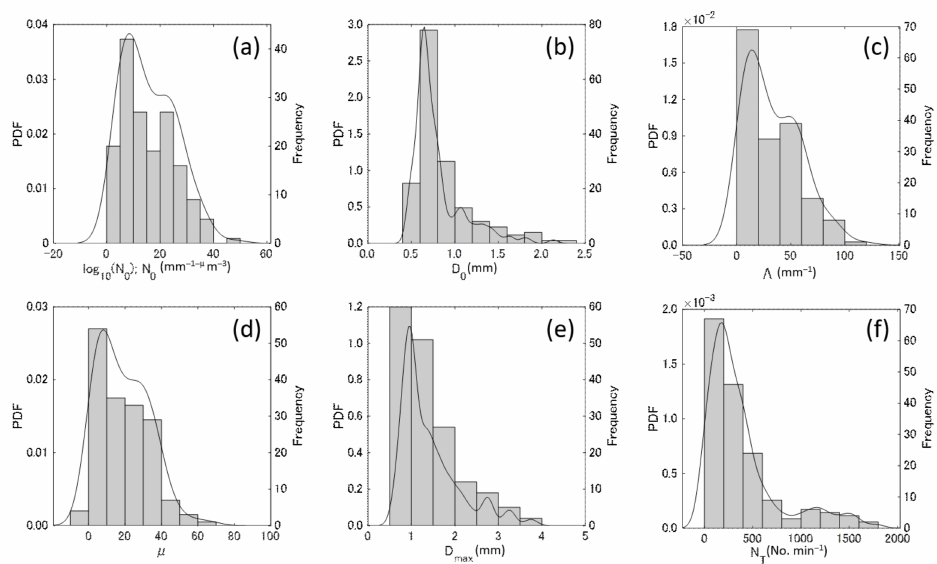
Figure 8. Histogram and probability density function of gamma PSD parameters including the ( a ) log of the intercept parameter (log 10 N 0 ), ( b ) median volume diameter ( D 0 ), ( c ) slope parameter ( Λ ), ( d ) shape parameter ( µ ), ( e ) maximum particle diameter ( D max ), and ( f ) total particle number ( N T ).